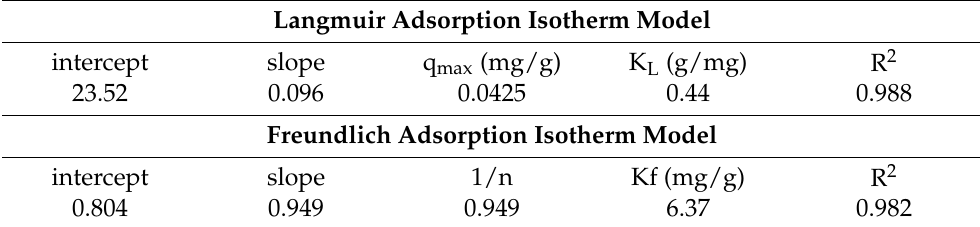
Table 4. Langmuir and Freundlich isotherm model parameters for the adsorption of the BR-5 on